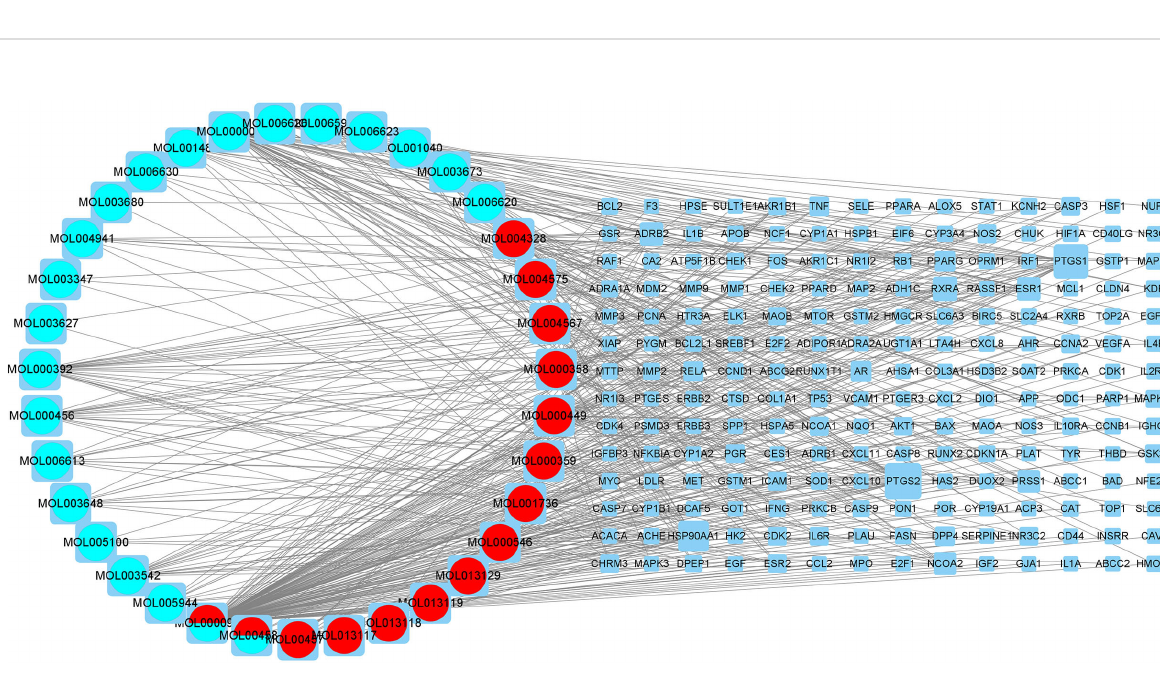
FIGURE 5 The interaction network of drugs-compounds-hub target genes-pathways. The circular nodes stand for the active ingredients of compound kushen injection and the blue square nodes stand for genes. The greater degree of the hub genes and compounds, the greater size of the nodes. The blue circular nodes represent the active ingredients of kushen and the red round nodes represent the active ingredients of baituling. The mixed colors represent ingredients containing two traditional Chinese